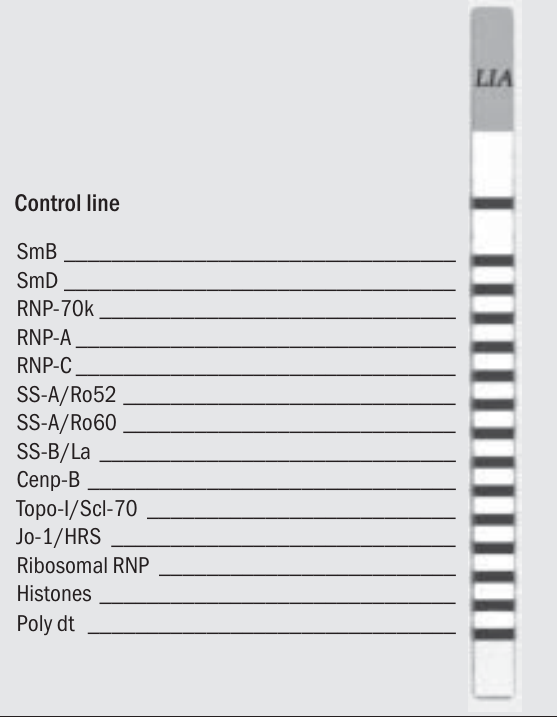
Figura – Fita do teste Inno-LIA™ ANA